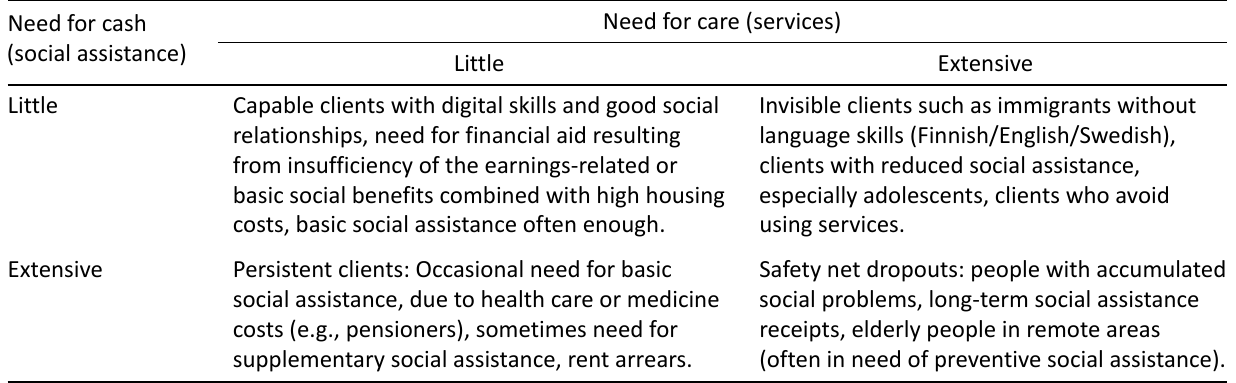
Table 1. Classification of clients according to the dimensions of cash and care. Need for cash (social